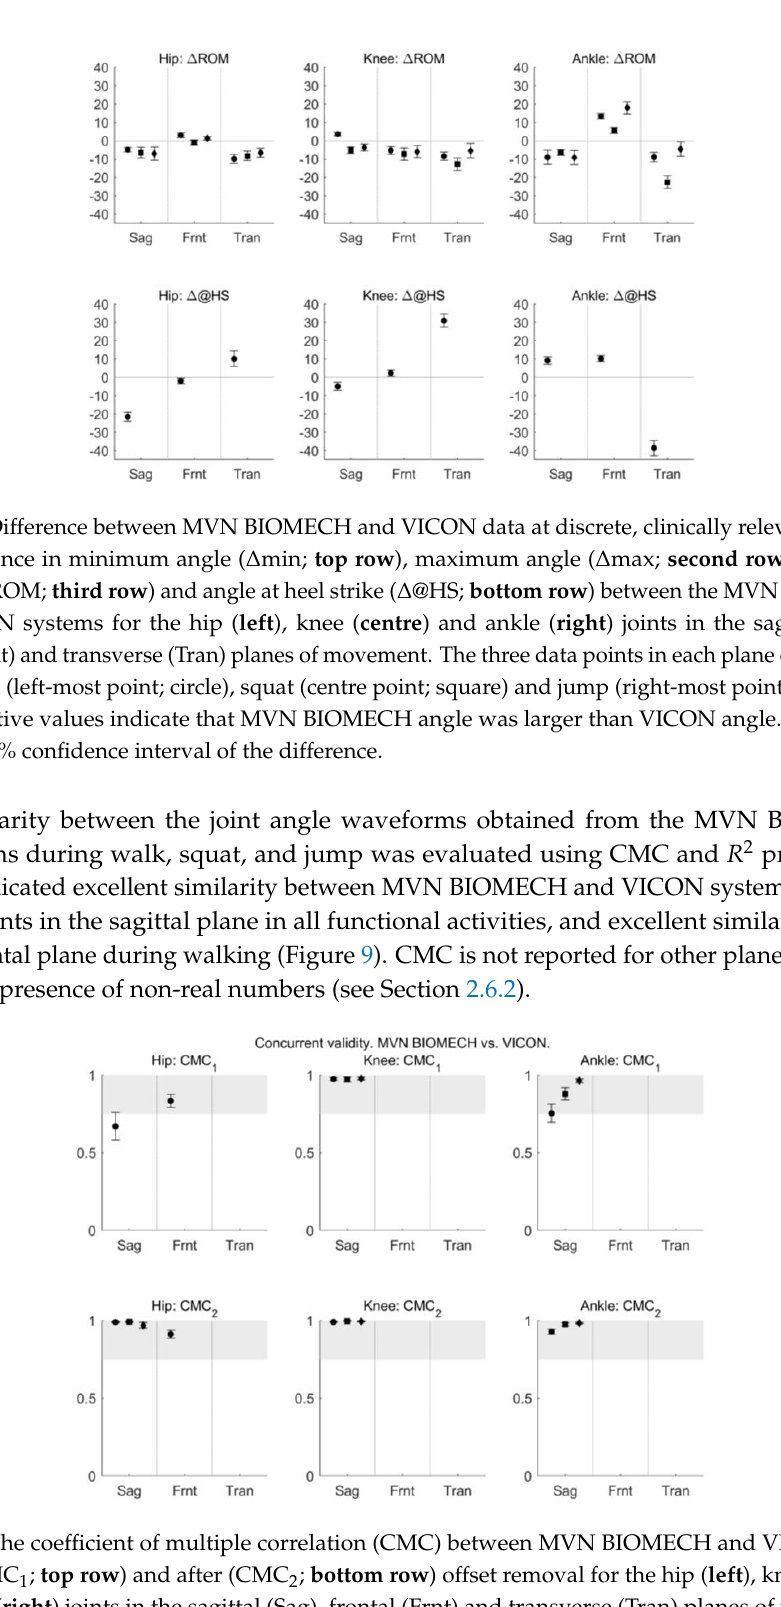
Figure 9. The coefficient of multiple correlation (CMC) between MVN BIOMECH and VICON data before (CMC 1 ; top row ) and after (CMC 2 ; bottom row ) offset removal for the hip ( left ), knee ( centre ) and ankle ( right ) joints in the sagittal (Sag), frontal (Frnt) and transverse (Tran) planes of movement. CMC is reported only for joints and planes where all values are real numbers [39]. Where there are three data points in each plane they correspond to the walk (left-most point; circle), squat (centre point; square) and jump (right-most point; diamond) tasks. Where there is only one data point it corresponds to the walk task. Error bars indicate 95% confidence intervals.